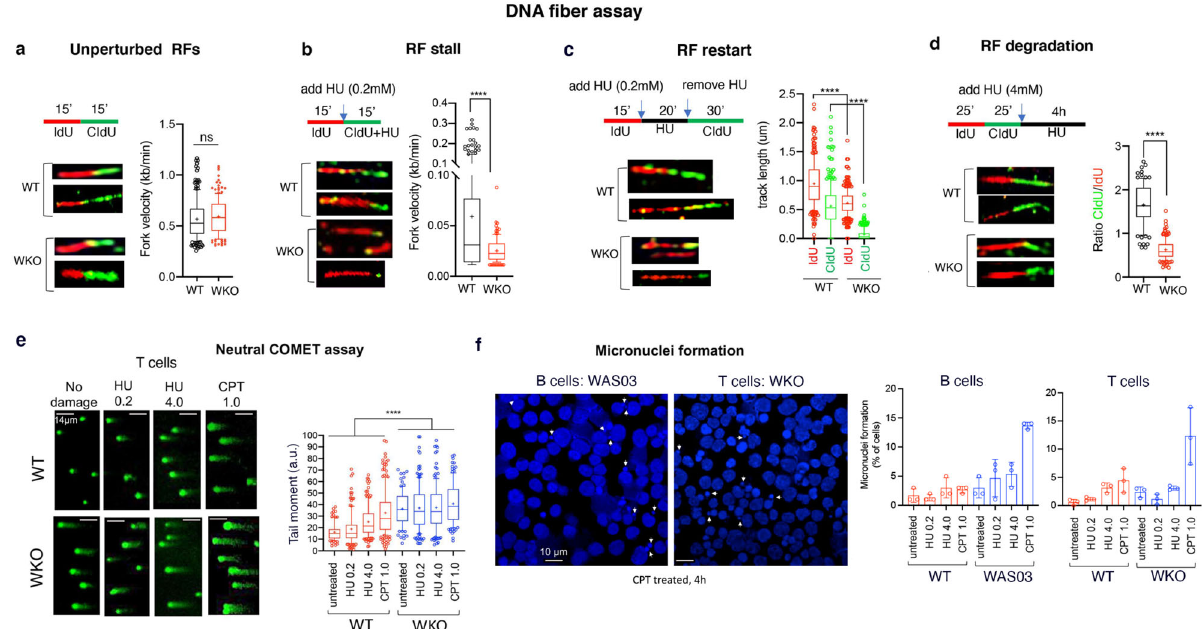
Fig. 5 WASp-de fi ciency undermines RF integrity and causes genome instability. a – d , DNA fi ber assays showing 4 different labeling protocols, their representative replication track images, and their corresponding RF statistics in human T cells (WT, WKO isogenic pair) under unperturbed (panel a) or HU-perturbed (panels b – d) conditions. For assays in which the 1st and 2nd labeling times were similar, RF velocity was calculated (panels a, b), whereas, when labeling times were dissimilar, the individual RF track length was calculated (panel c). For quantifying RF degradation (panel d), the ratio of 2nd:1st labeled track lengths was calculated only in those tracks that showed sequential, but not overlapping, dual-labeling. The box-and-whisker plots (whiskers @10-90%, horizontal bar denotes median, “ + ” denotes mean) are from n = 150 tracks analyzed from 3 independent experiments. Mann-Whitney unpaired two-tailed nonparametric p-value: **** <0.0001; ns, nonsigni fi cant. See Supplementary Fig. S4 for additional RF data in human B cells. e , Representative confocal IF images of the neutral comet assay reporting on the frequency of DSBs in human T cells (WT, WKO), untreated or treated with indicated genotoxins and doses for 4 h. The box-and-whisker plots (whiskers @10-90%, horizontal bar denotes median, “ + ” denotes mean) reporting on the tail- moment are from n = 150 cells analyzed, Mann-Whitney unpaired two-tailed nonparametric p -value: **** <0.0001. a.u. denotes arbitrary units. Scale bar: 14 μ m. f , Left , Representative confocal IF images of micronuclei formation (indicated by arrows) in DAPI-stained WASp-de fi cient T and B cells are shown for the CPT condition at 4 h. Right , statistical bar graph data, mean + SEM, n = 150 cells for all genotoxin conditions from n = 3 independent assays. Scale bar: 10 μ